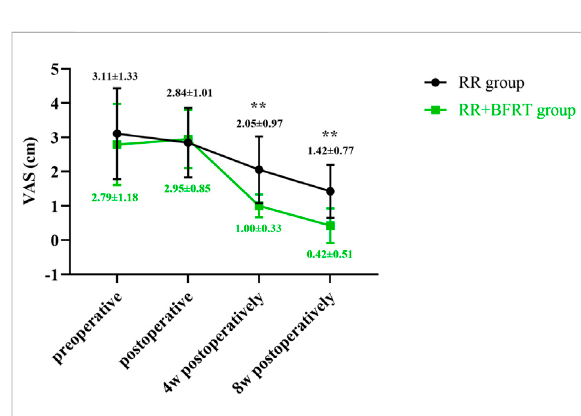
FIGURE 11 Comparison of VAS scores between RRgroup and RR+ BFRT group at different time points (cm). “ ** ” indicates a signi fi cant change ( p < 0.01). Values are presented as mean ± SD. RR Group: routine rehabilitation group; RR + BFRT Group: routine rehabilitation + blood fl ow restriction training group.